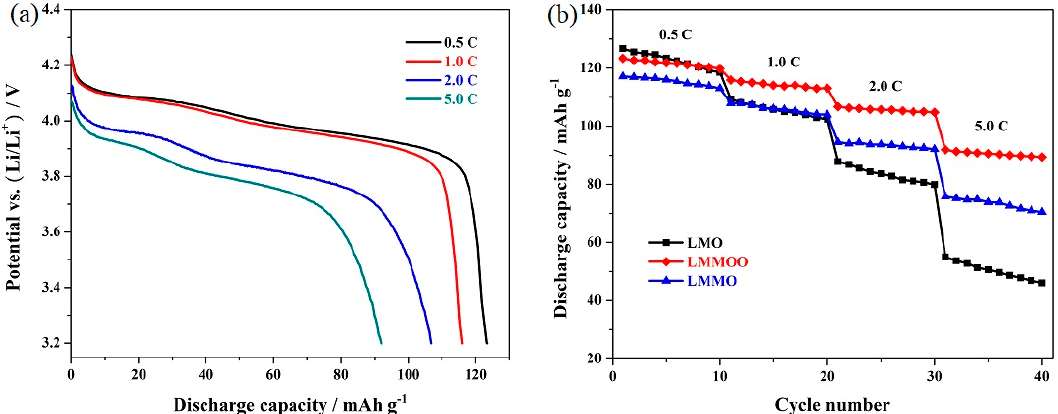
Figure 5. ( a ) Representative discharge curves of the octahedral LiMn 1.95 Mg 0.05 O 4 sample and ( b ) rate capability of the LiMn 2 O 4 , LiMn 1.95 Mg 0.05 O 4 , and octahedral LiMn 1.95 Mg 0.05 O 4 samples.